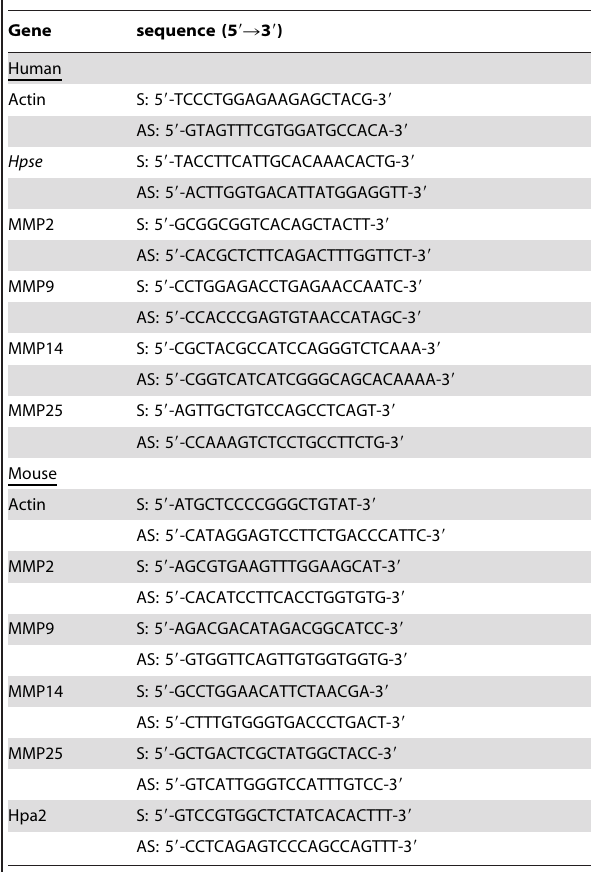
Table 2. Real Time PCR